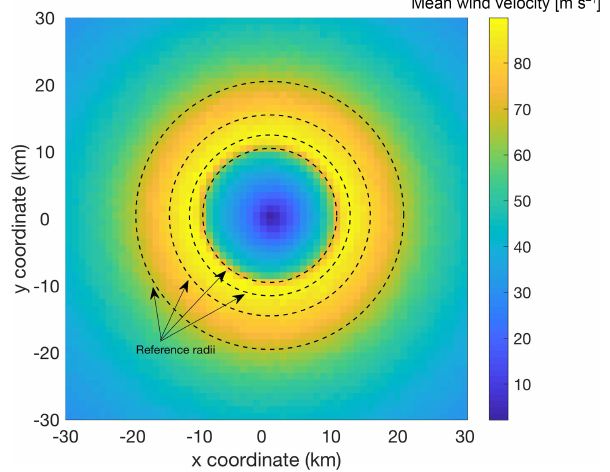
Figure 1. Mean horizontal wind speed near the DTU turbine hub height of 119m for the entire 10min simulation on a 1km × 1km grid. The four dashed circles represent the reference radii of 10, 12, 15, and